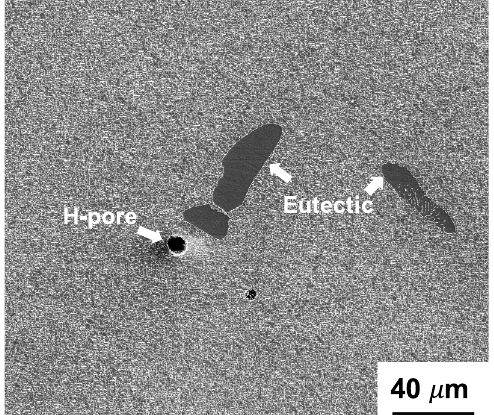
Figure 3. Homogenization pore grown near the eutectic in SX superalloy after standard heat treatment.